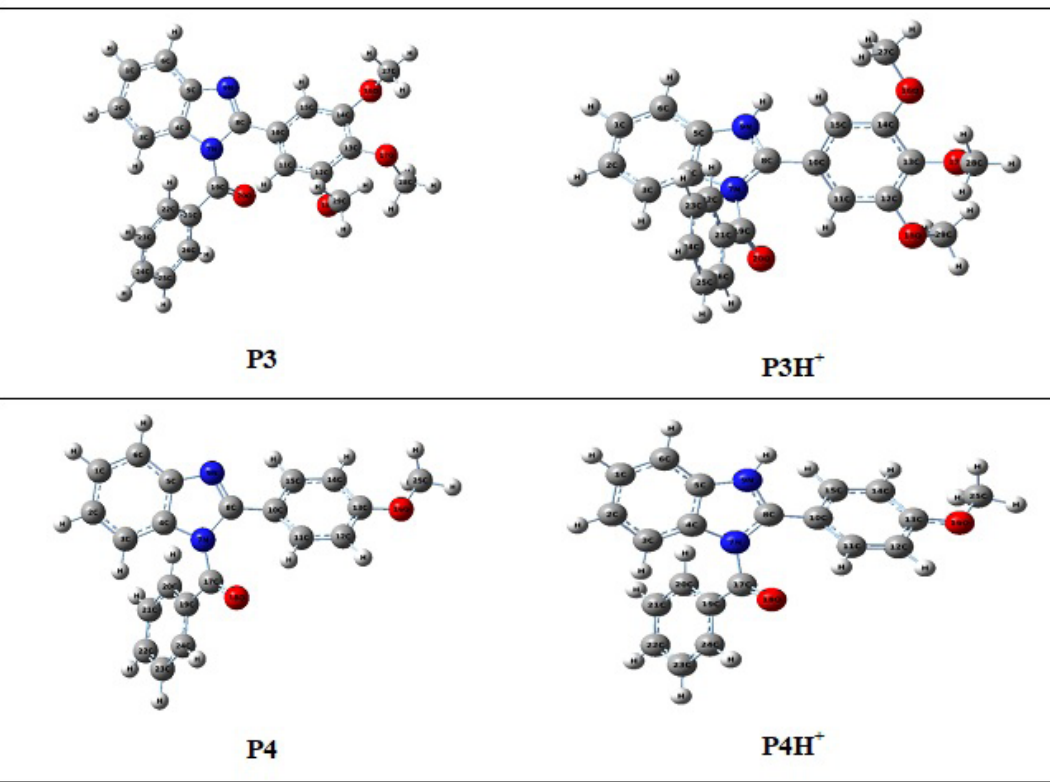
Figure 13. Optimized structures of neutral and protonated forms of P3 and P4 calculated by DFT with B3LYP / 6-31g (d,